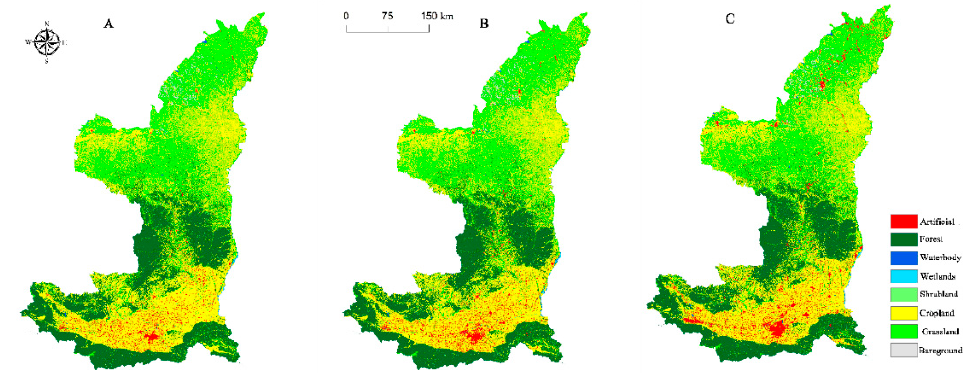
Figure 3. Land-cover maps of the YRBS for 2000–2020. ( A ) 2000, ( B ) 2010, and ( C ) 2020.